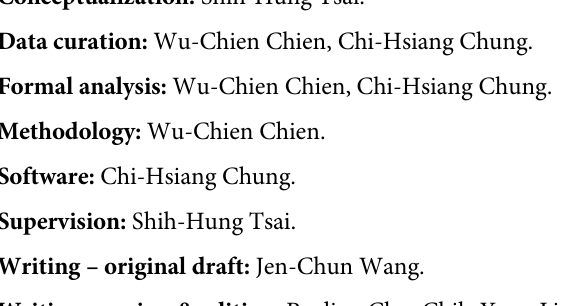
S1 Fig. Histogram of the ages at the time of HS and HRI onset.